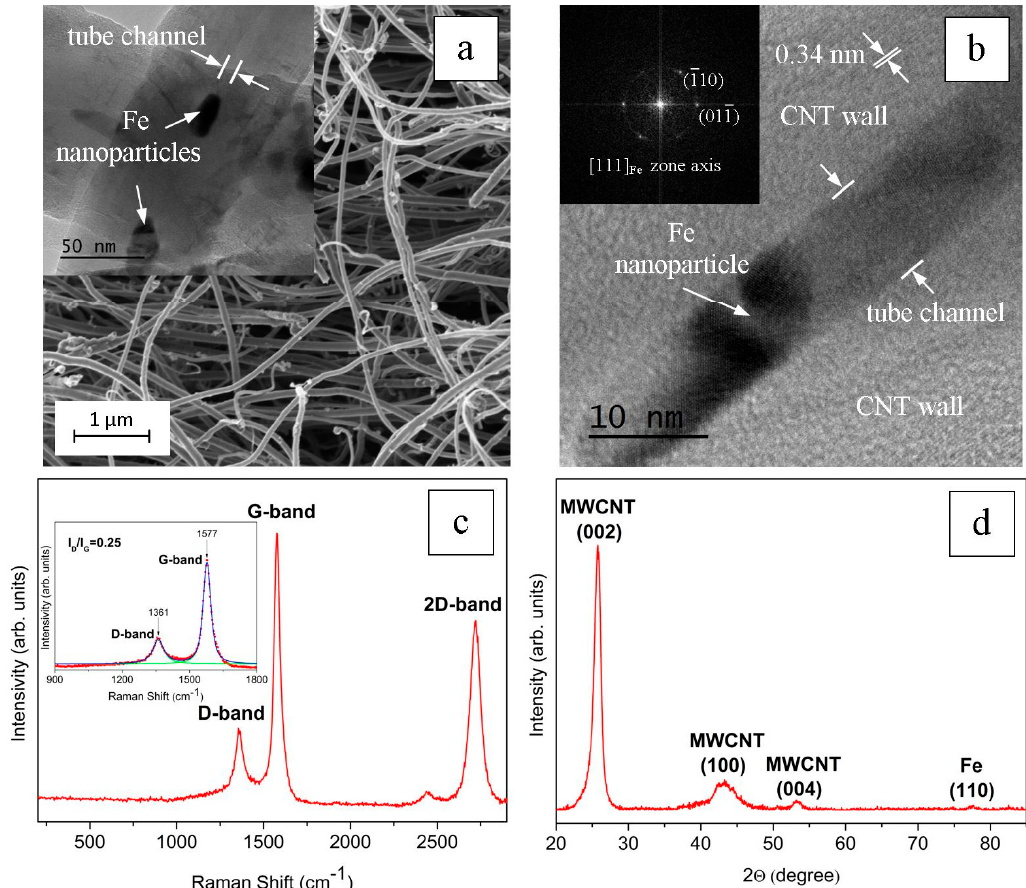
Figure 2. SEM image of MWCNTs ( a ). The inset in Figure 2a shows a TEM image of a nanotube with iron nanoparticles in the internal channel. An HRTEM image of an MWCNT with an iron nanoparticle in the inner channel ( b ): the Fourier transform of the image of the crystal lattice of iron is shown in the inset in the upper left corner in Figure 2b. In the inset in Figure 2a and in Figure 2b, the pointing arrows indicate iron nanoparticles, and the dimensional arrows indicate the width of the inner channel of the nanotube. Raman spectrum ( c ) and XRD pattern ( d ) of